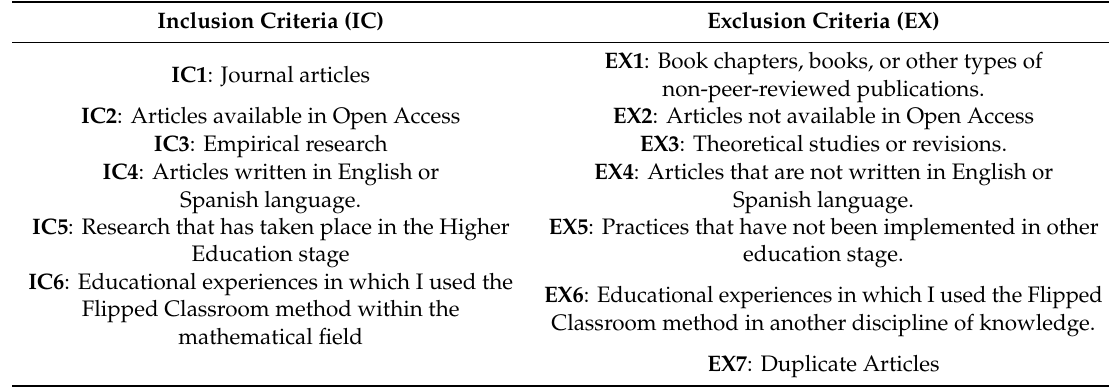
Table 1. Inclusion and exclusion criteria.